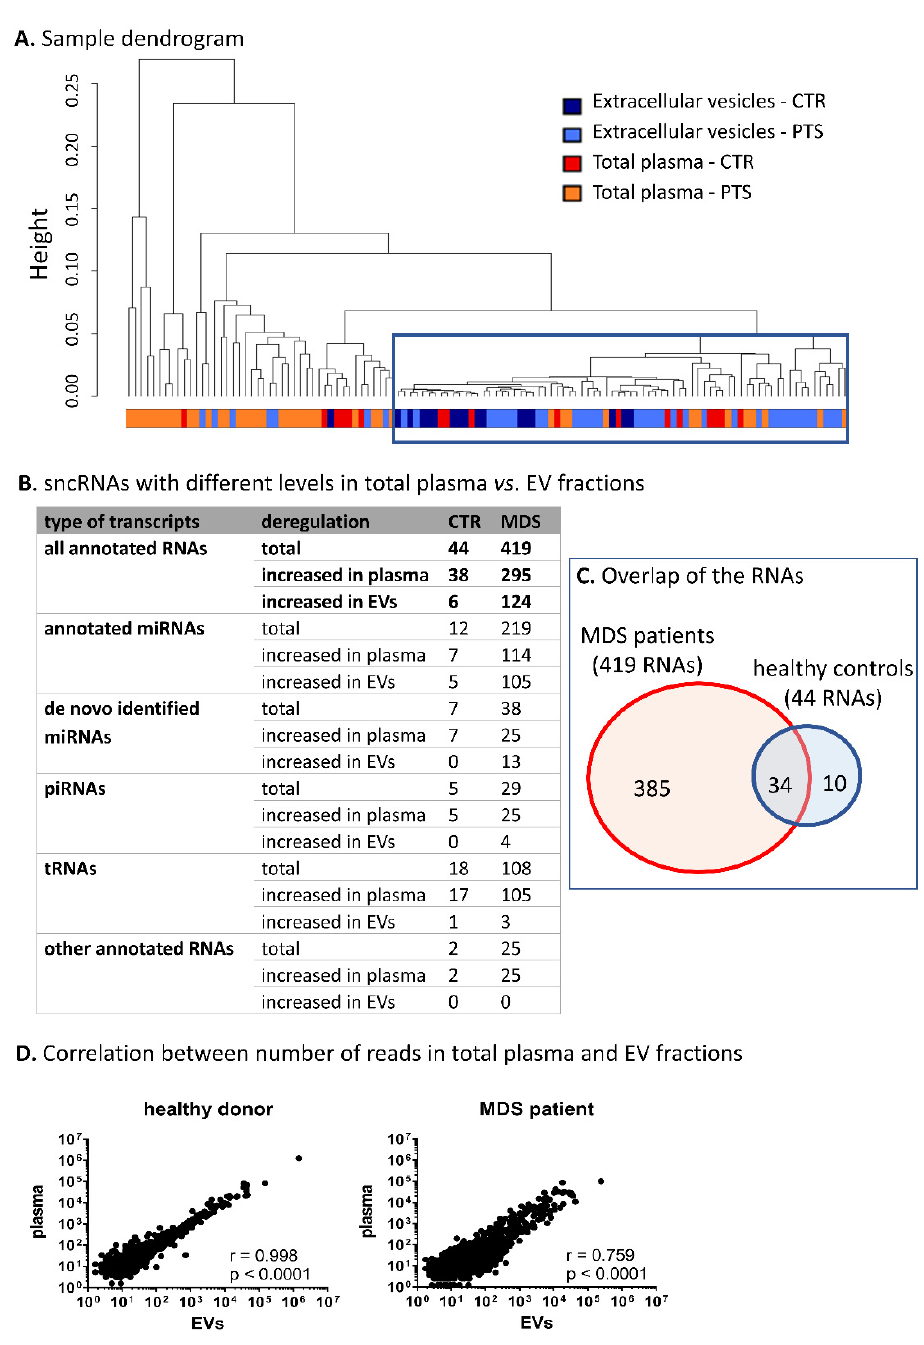
Figure 2. Characterization of circulating small noncoding RNA (sncRNA) profiles of total plasma vs. EVs. ( A ) Hierarchical cluster analysis of samples based on all RNA-seq data. The blue frame highlights the clustered extravesicular samples. CTR—healthy controls, PTS—MDS/AML patients. ( B ) SncRNAs with different levels between total plasma and paired EV samples. Only the RNAs with |logFC| > 1 and q < 0.05 were considered. ( C ) The overlap of the RNAs between MDS patients and healthy controls. ( D ) Correlation between normalized number of reads in total plasma vs. paired EV samples in a typical healthy control or an MDS patient.